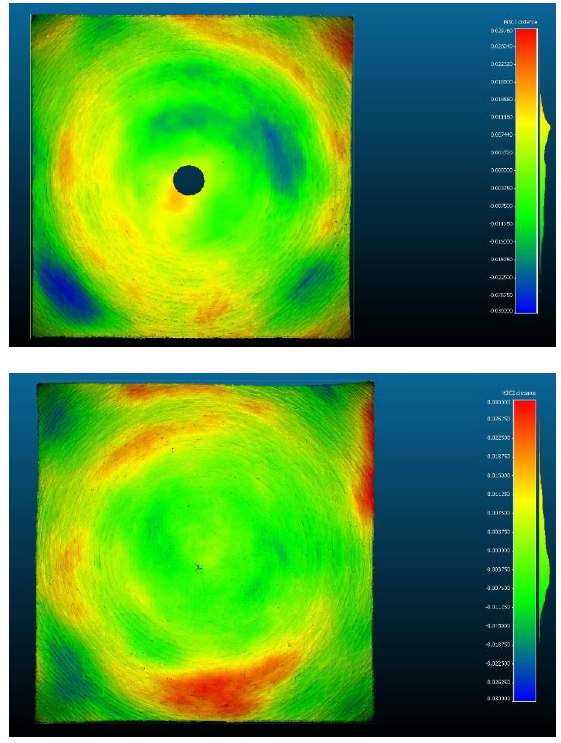
Figure 6. Deviation maps of the vault A (Up) and B